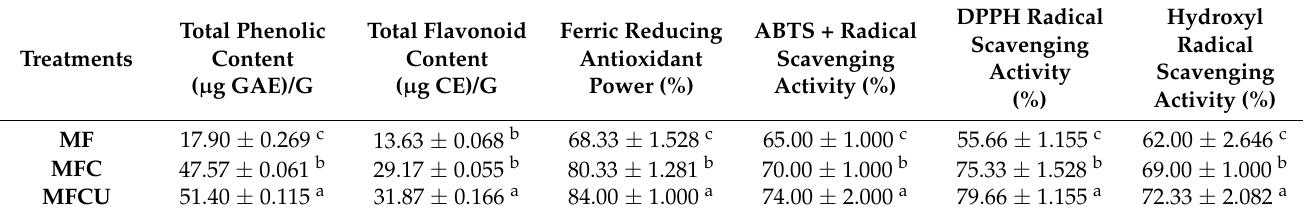
Table 3. Phytochemical and antioxidant activities of mung bean flour-based films processed under different